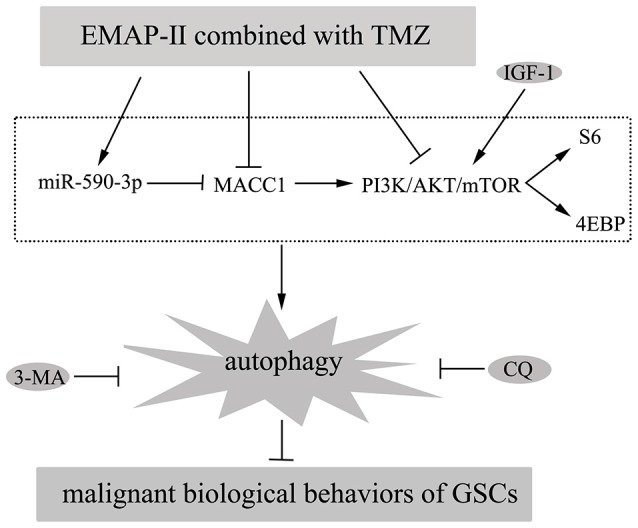
Diagrammatic presentation of the mechanism of EMAP-II in combination with TMZ suppressed malignant biological behaviors of GSCs via miR-590-3p/MACC1 inhibiting PI3K/AKT/mTOR signaling pathway.